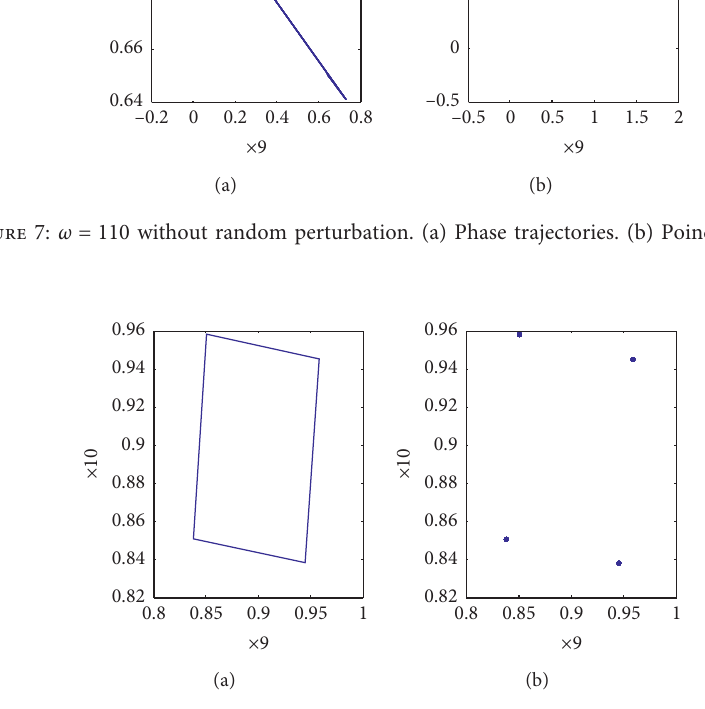
Figure 8: ω � 170 without random perturbation. (a) Phase trajectories. (b) Poincare